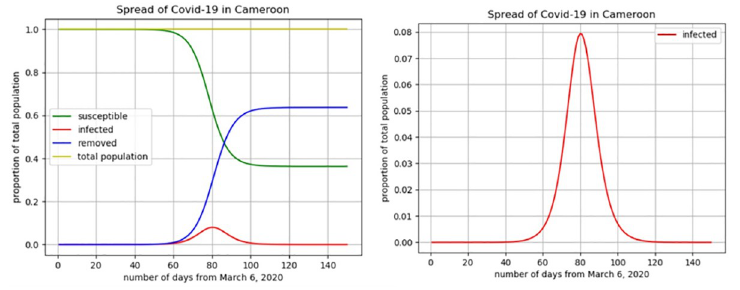
Fig 7. Evolution of the coronavirus disease in